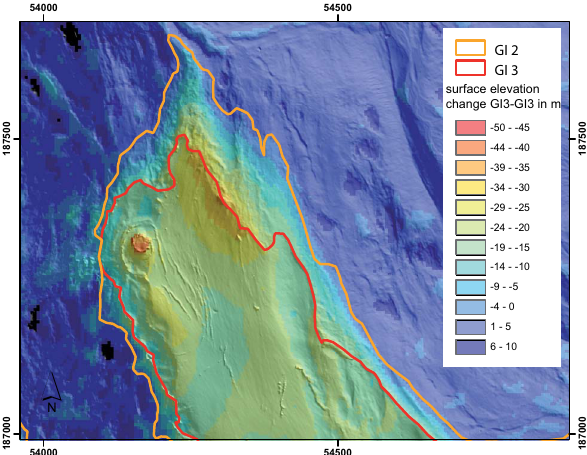
Figure 5. The elevation change between GI 2 and GI 3 superim- posed on a hillshade shows that the elevation changes can help to delineate the actual (maximum elevation change) and previous (outer minimum of elevation change) position of the glacier margin (position of the subset shown in Fig.